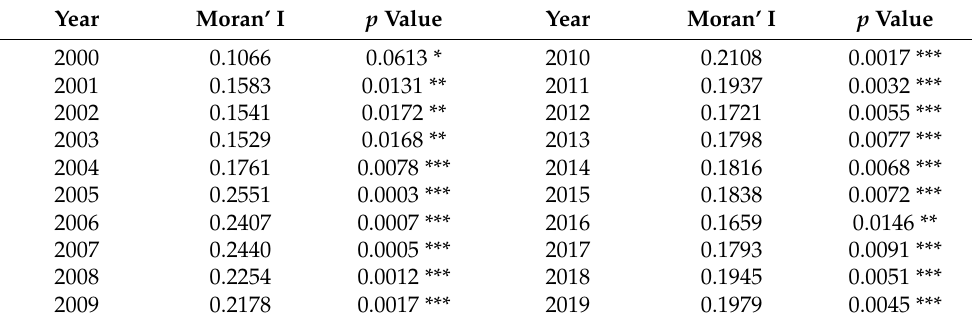
Table 4. Moran’s I of tourism carbon emissions efficiency from 2000 to